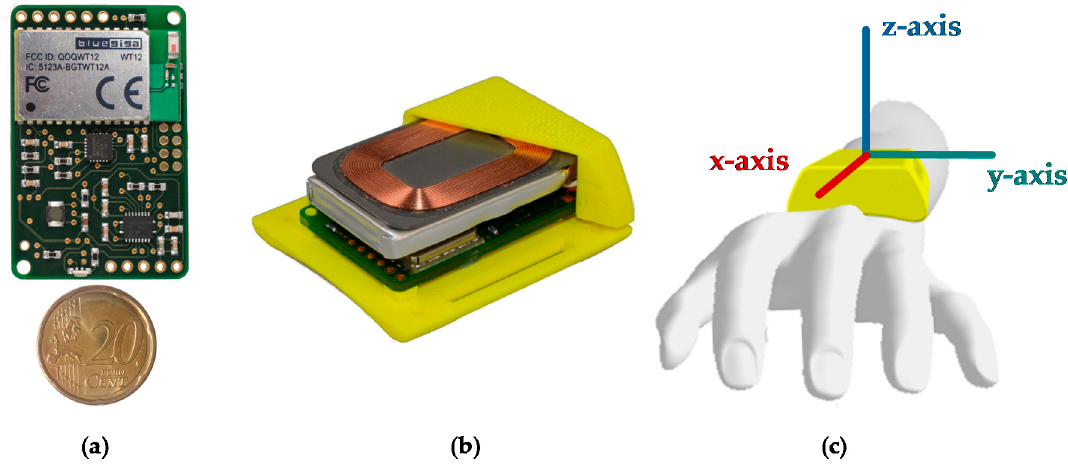
Figure 2. The sensor board ( a ) in comparison with a 20 cent coin and ( b ) in the casing; ( c ) axis of the sensor unit placed on the avatar’s arm.